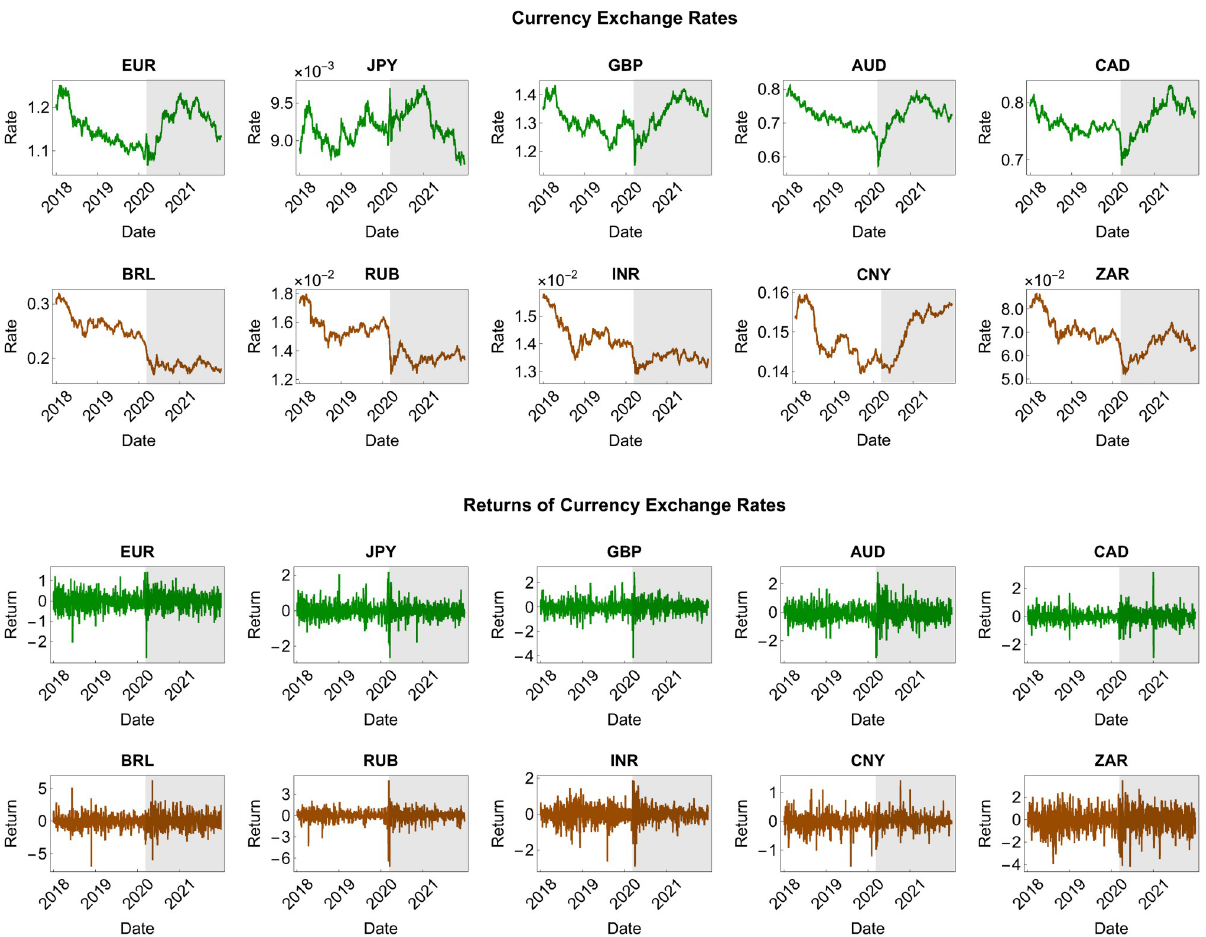
Fig 2. Daily exchange rates of ten currencies and their returns. We denominate each currency exchange rate in US dollars. Green and brown represent the currencies of the advanced and emerging countries, respectively. Meanwhile, the shaded region indicates the COVID-19 period